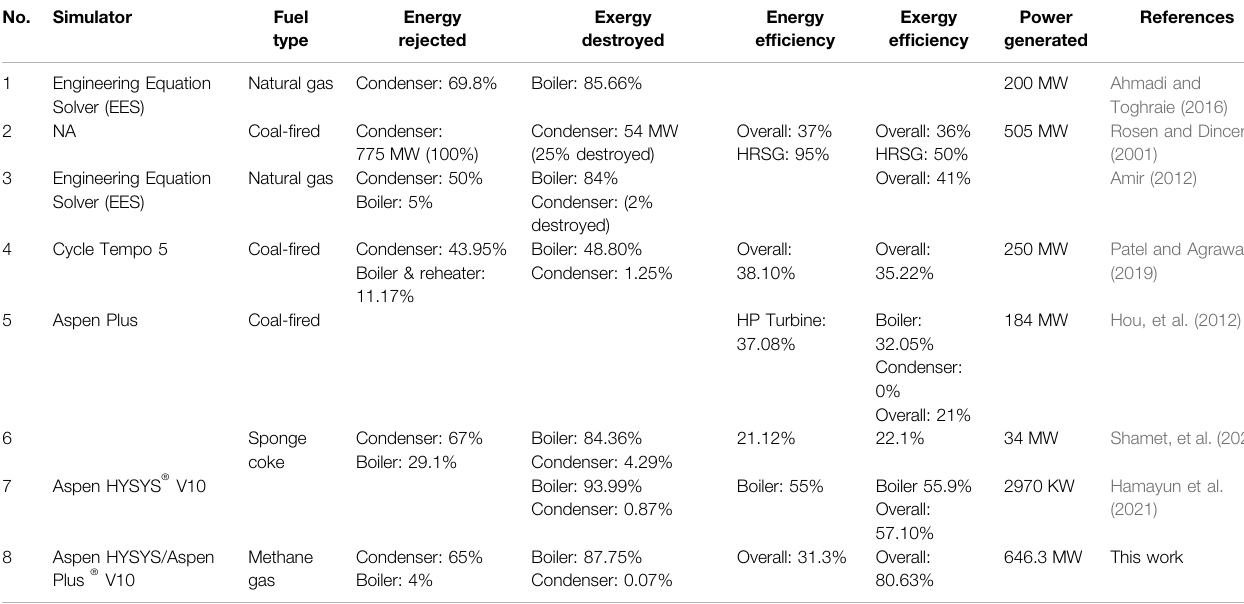
TABLE 4 | Model validation summary on steam power plant. No.